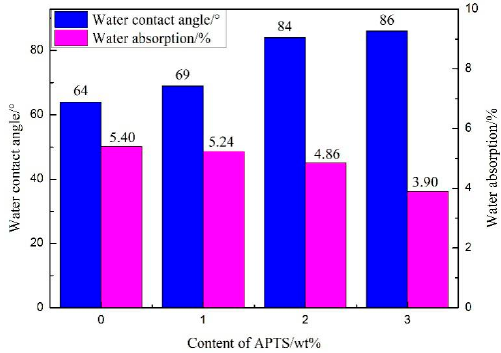
Figure 8. Water contact angles and water absorption of different WPU films.